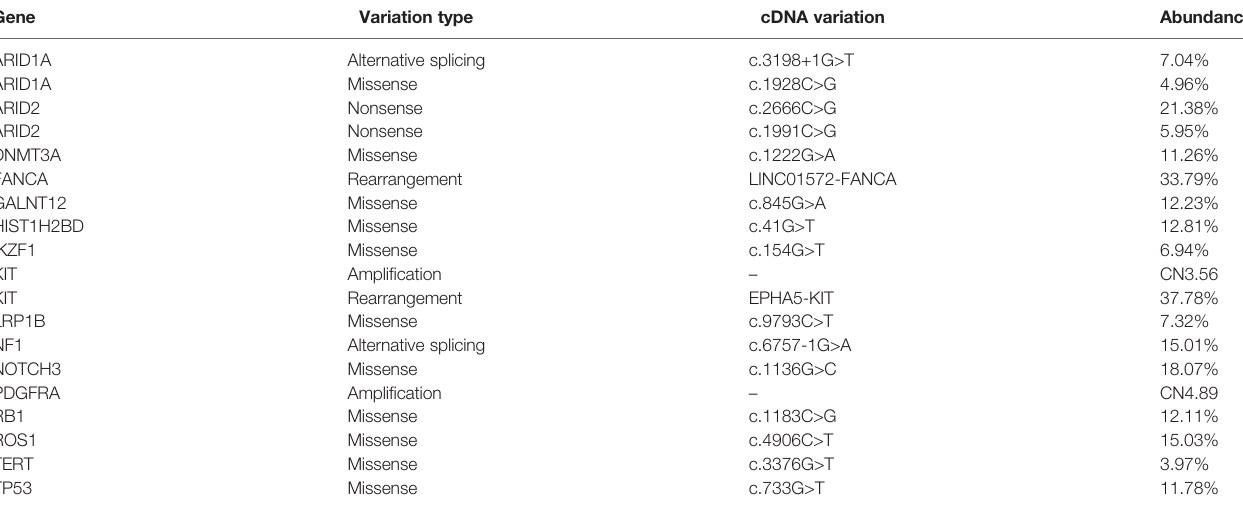
TABLE 1 | Summary of gene mutations concluded from NGS